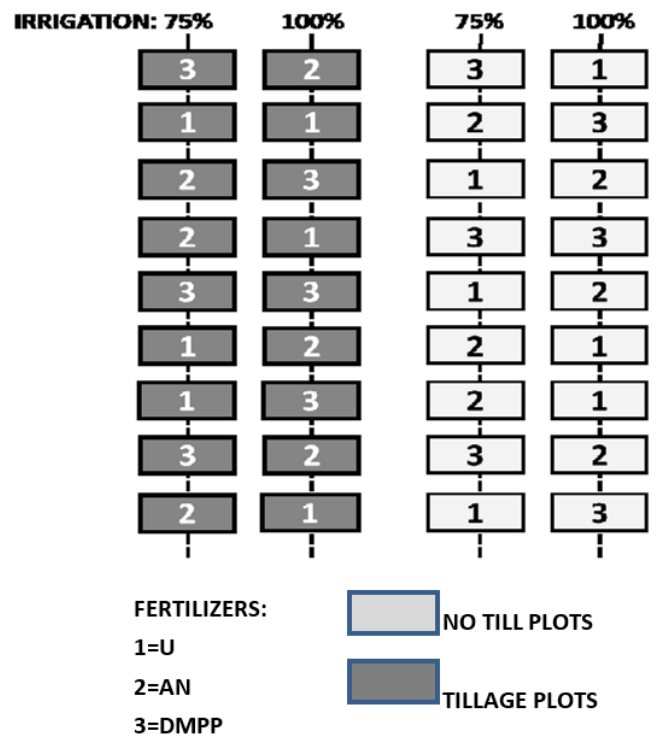
Figure 1. Experimental design of the test plots. U: urea; AN: ammonium nitrate; DMPP: ammonium sulphate nitrate with DMPP nitrification inhibitor.